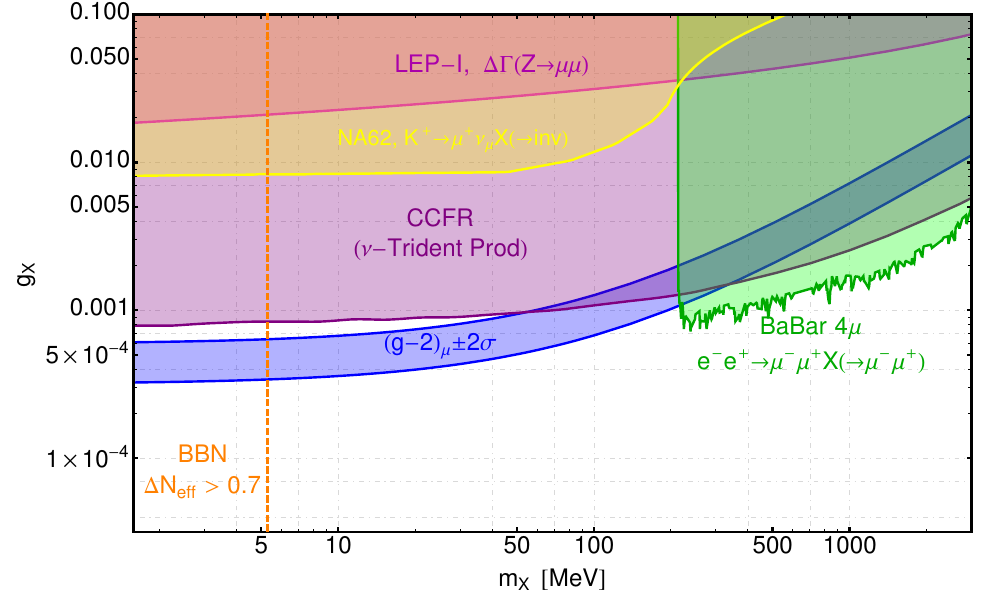
Figure 2 . The bounds from the previous muon-philic gauge boson searches (purple, magenta, green and yellow), the indirect bound from BBN constraint (orange), and ( g eters (blue).